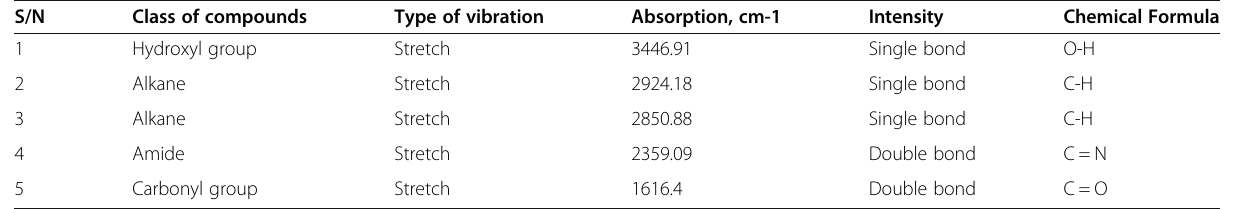
Table 4 Characteristic FTIR absorption frequency of organic functional group in crude hot water infusion extract of Cassava biogas